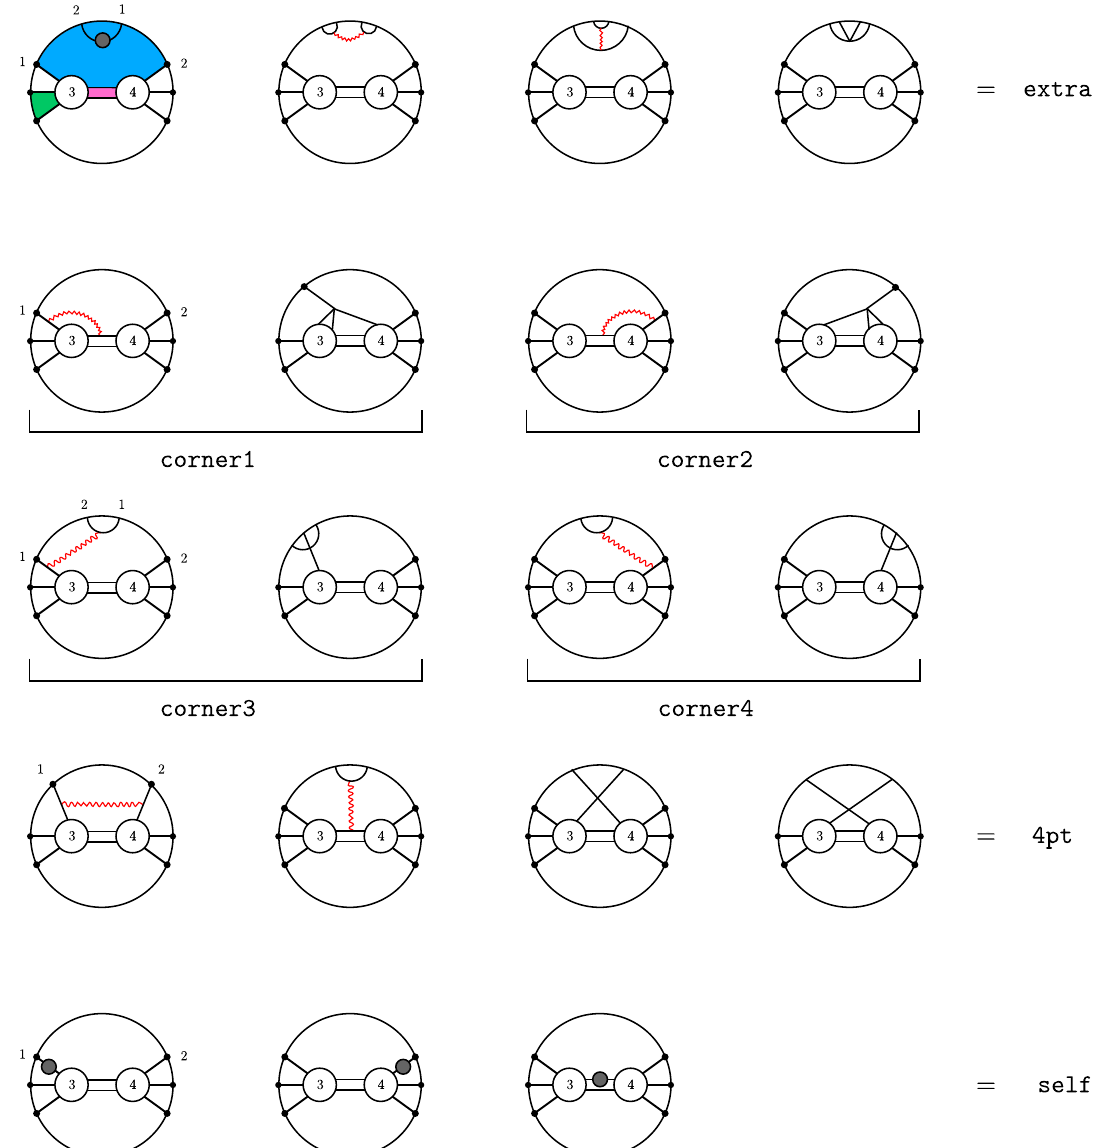
Figure 47 . One-loop corrections to the four-point function. The diagrams extra correspond to the second line in (M.6) and the others to the (cid:12)rst line therein. For the four-point functions, there are three di(cid:11)erent kinds of faces; the two-point faces, the three-point faces and the four-point faces (colored in di(cid:11)erent colors in the (cid:12)rst diagram). Here we listed corrections associated with the four-point face in the (cid:12)rst